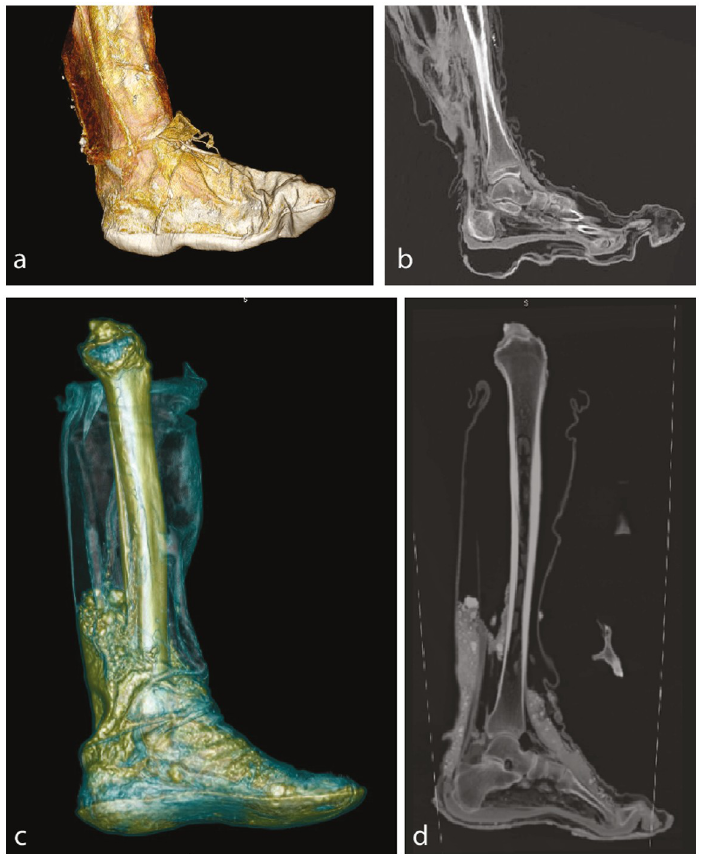
Fig 4. Comparison of shoes for SM1 vs SM4. a) 3D volume rendering of the shoe of SM4, b) sagittal MPR, c) 3D volume rendering of the lower leg of the assumed SM1, d) corresponding MPR. Note that no socks are worn.